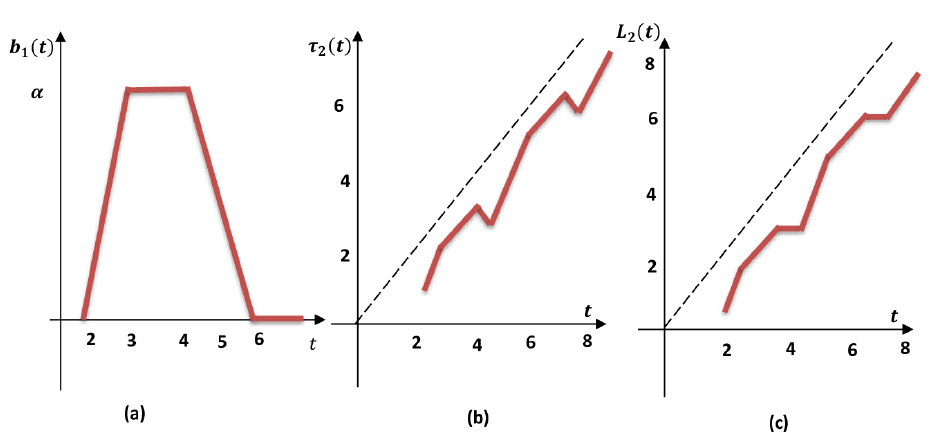
Figure 1. The graphs of the functions b 1 ( t ) , τ 2 ( t ) , and L 2 ( t ) are shown in subfigures ( a ), ( b ), and ( c ),